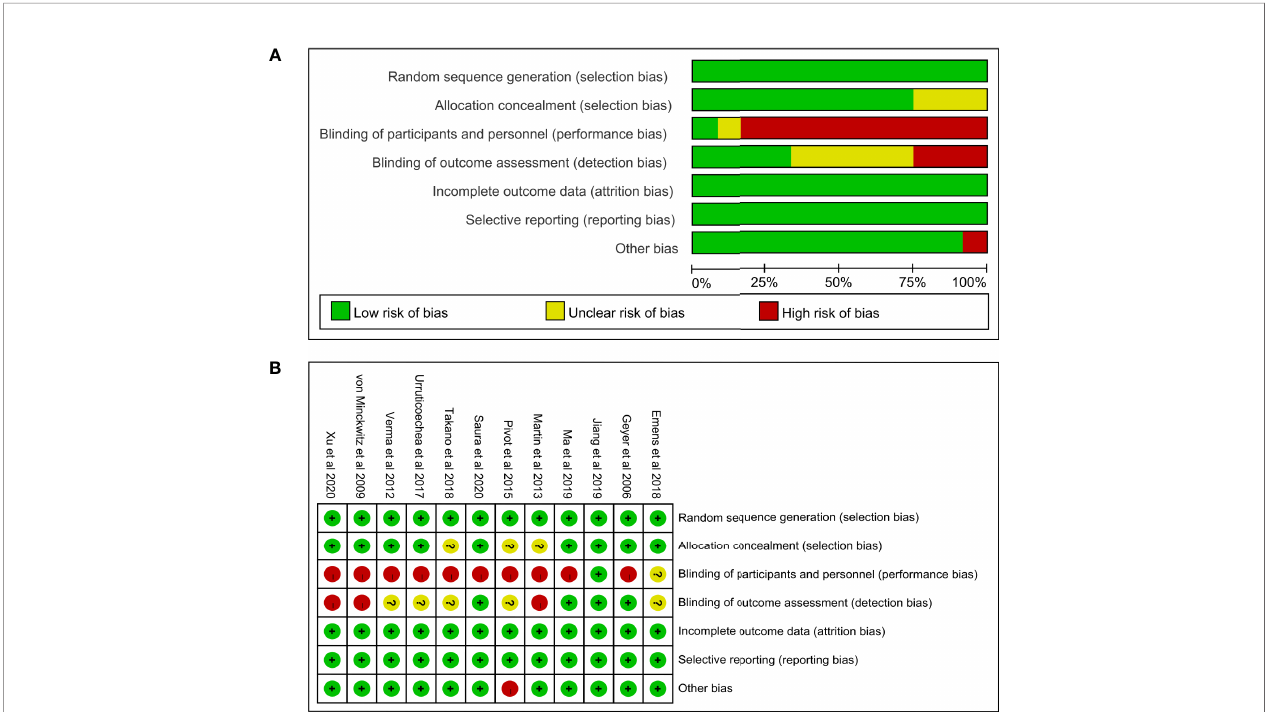
FIGURE 2 | (A) Risk of bias graph and (B) summary. In the risk of bias graph, the length of each rectangle was proportional to the number of studies being assessed as corresponding risk of bias. In the risk of bias summary, the risk of bias of each domain in each included study was listed.